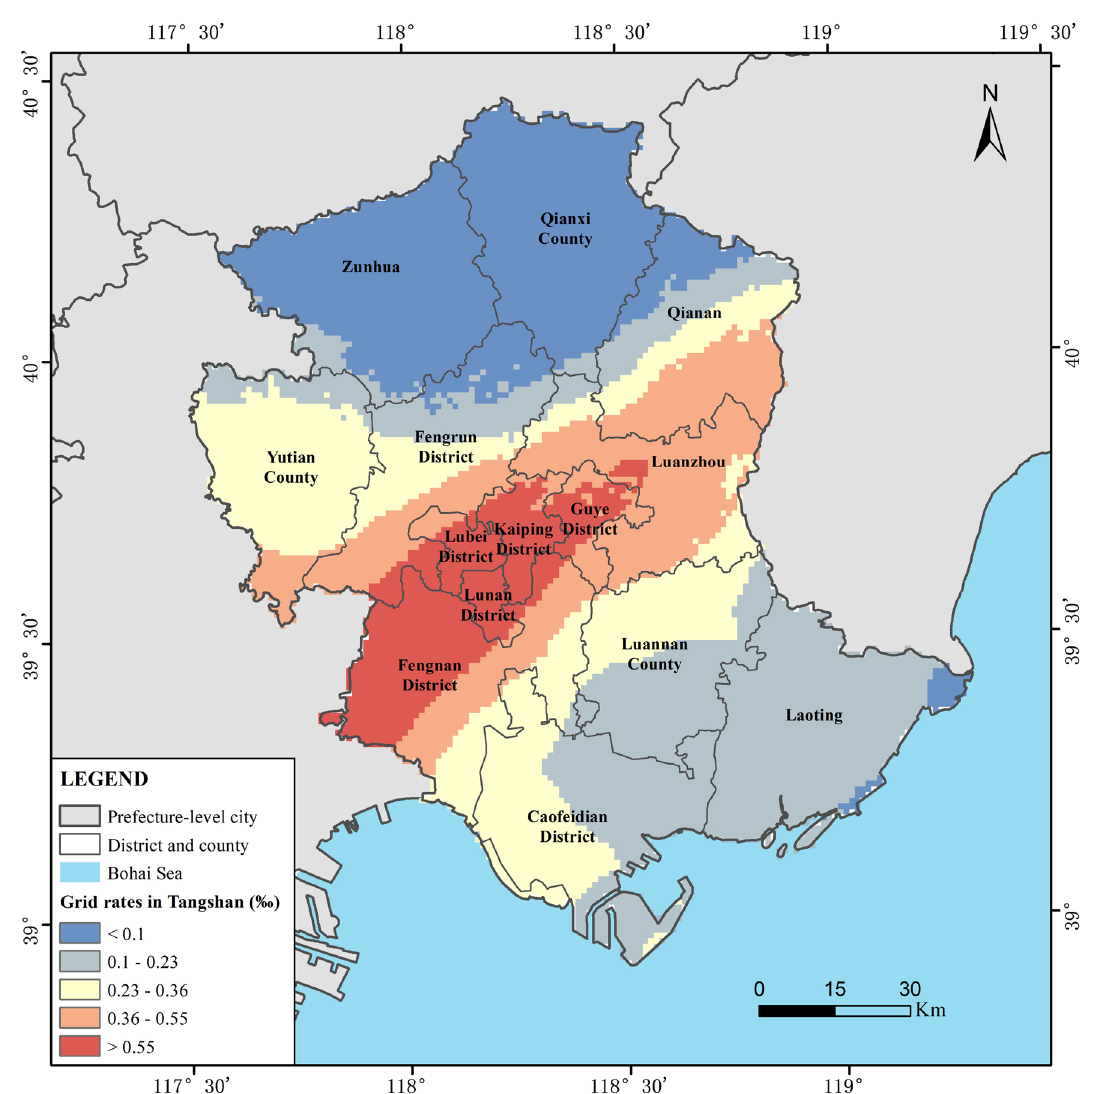
Fig. 3 Rate distribution within the 0.01° × 0.01° grid areas in Tangshan